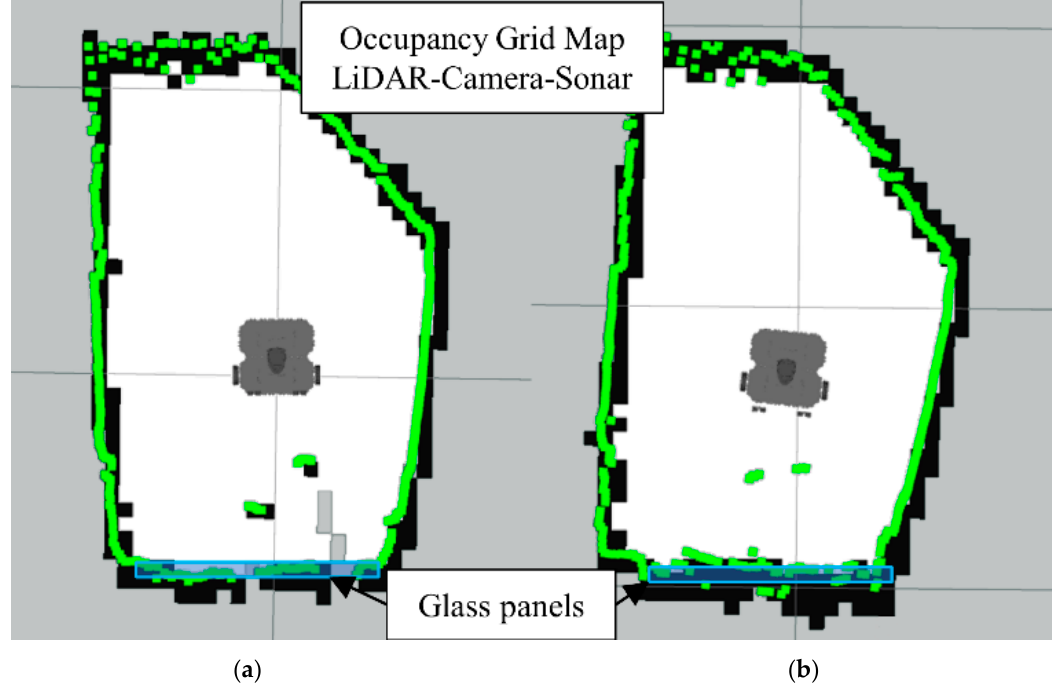
Figure 16. Occupancy grid maps showing the: ( a ) Ground truth (reference map); ( b ) LiDAR-Camara-Sonar fusion generated map.